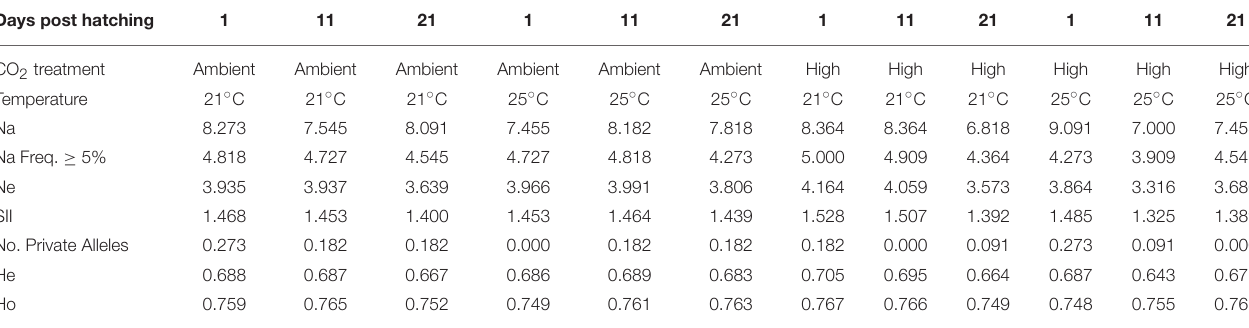
TABLE 1 | Genetic diversity of juvenile yellowtail kingfish ( Seriola lalandi ) reared at 21 ◦ C and 25 ◦ C in current-day ambient and elevated CO 2 and sampled at 1, 11, and 21 days post hatching. Days post